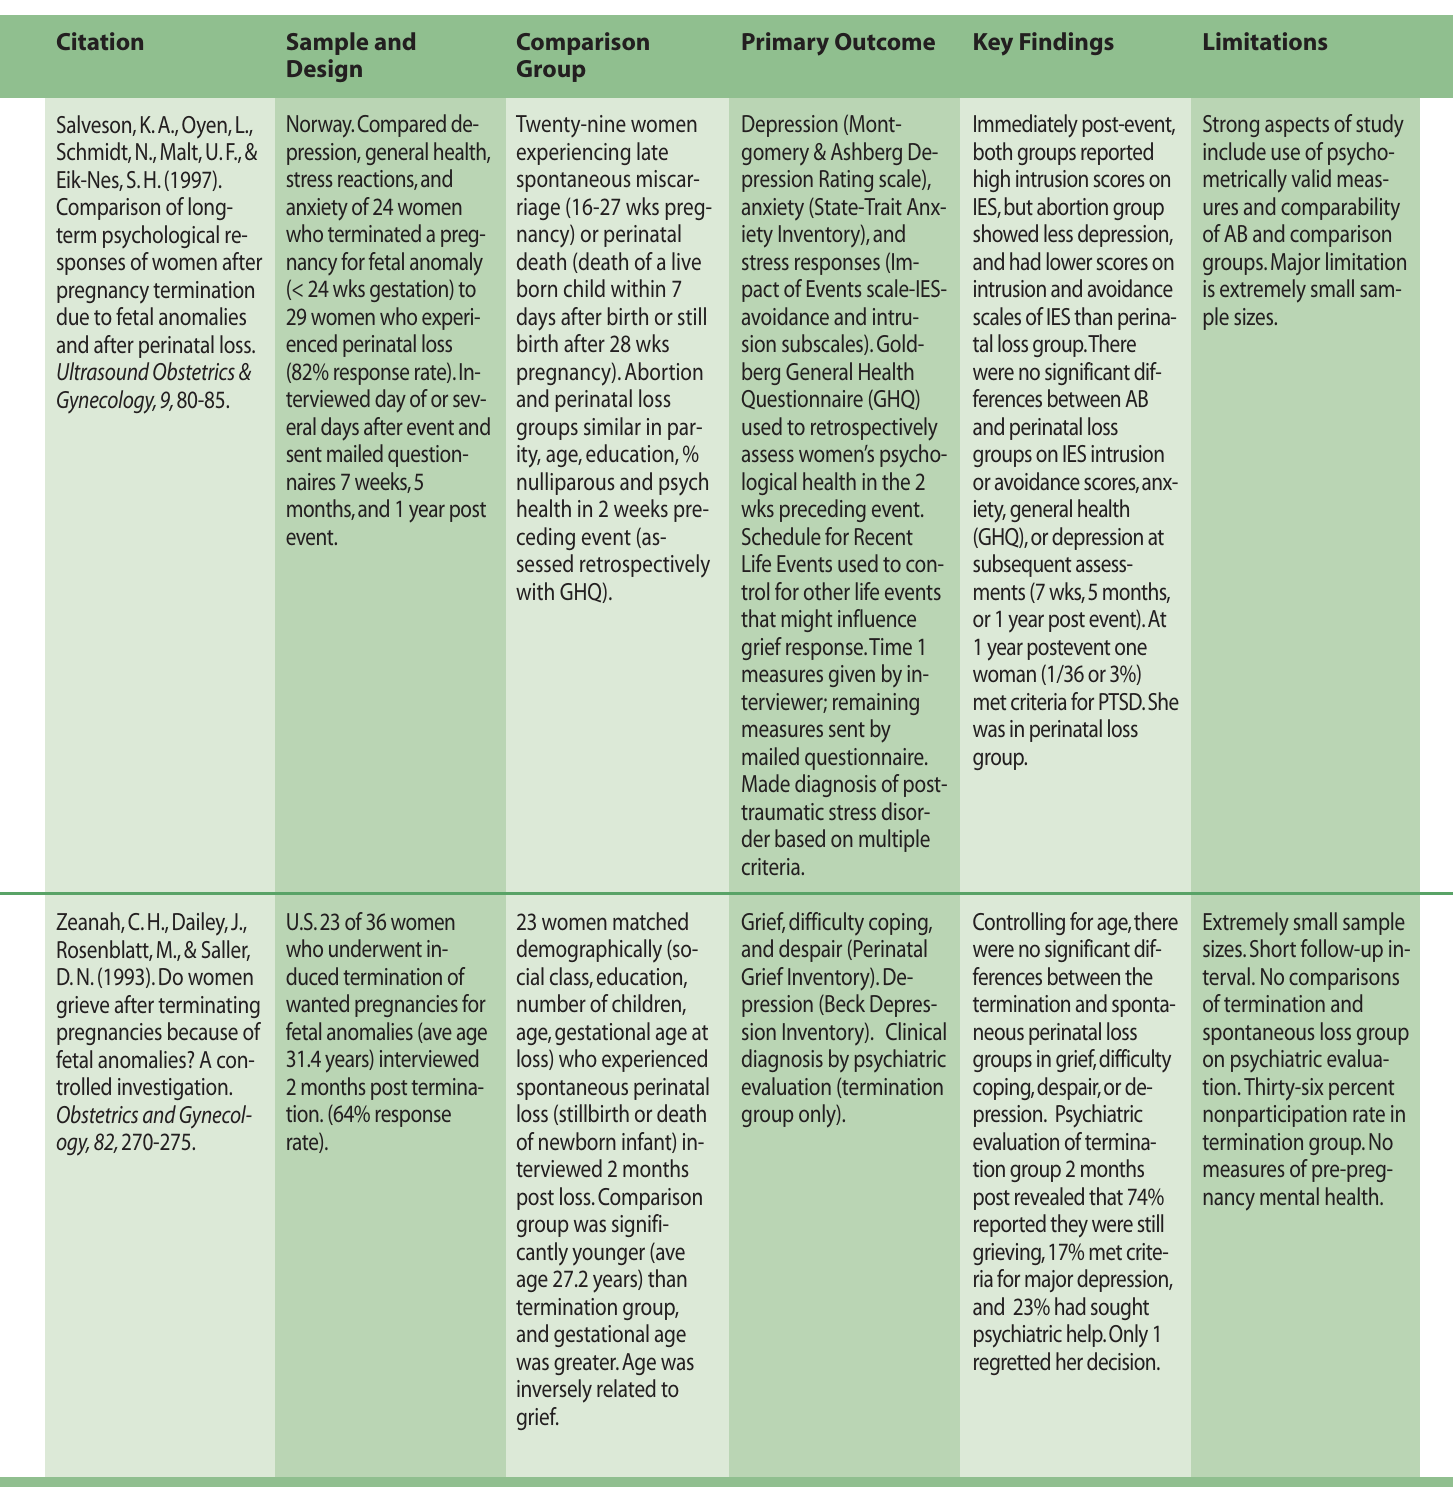
Table 4: Abortion for Reasons of Fetal Anomaly